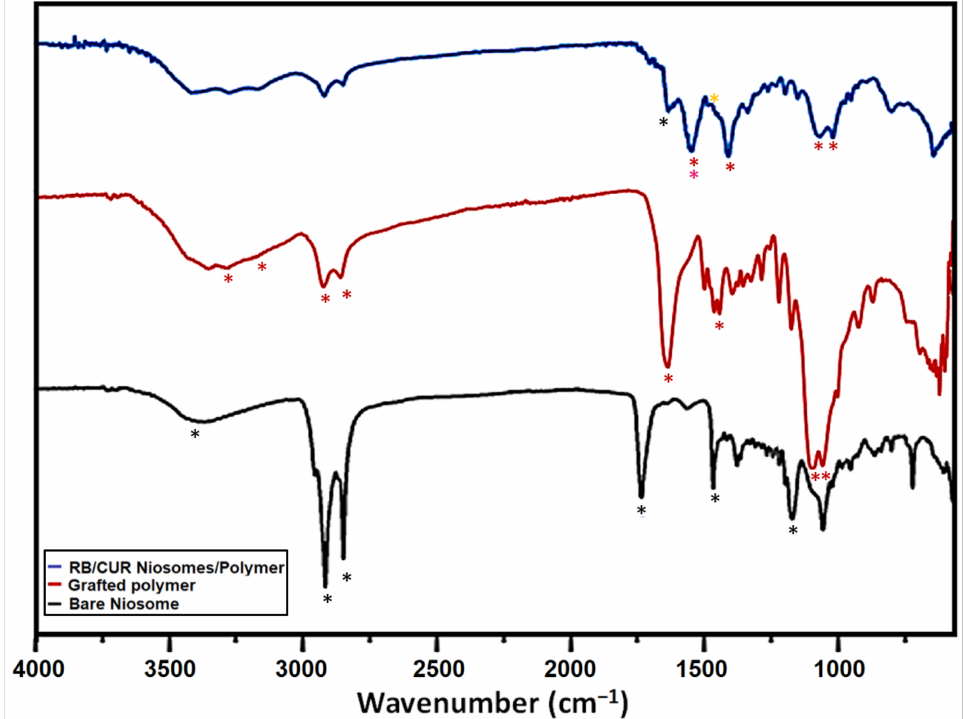
Figure 3. FTIR spectrums of bare niosome, grafted polymer, and complete complex (RB/CUR nio- some/polymer). Asterisks with different colors are used to distinguish bands on different compounds. Black (*), Red (*), Orange (*), and Pink (*) are attributed to the bands of niosome, grafted polymer, curcumin, and RB, respectively.